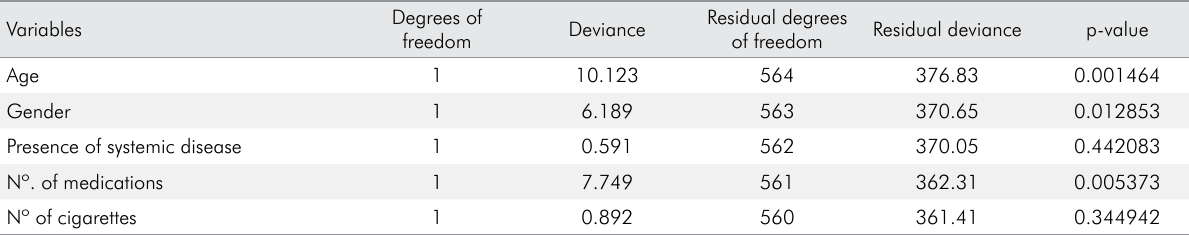
Table 2. Logistic regression for associated factor analysis.